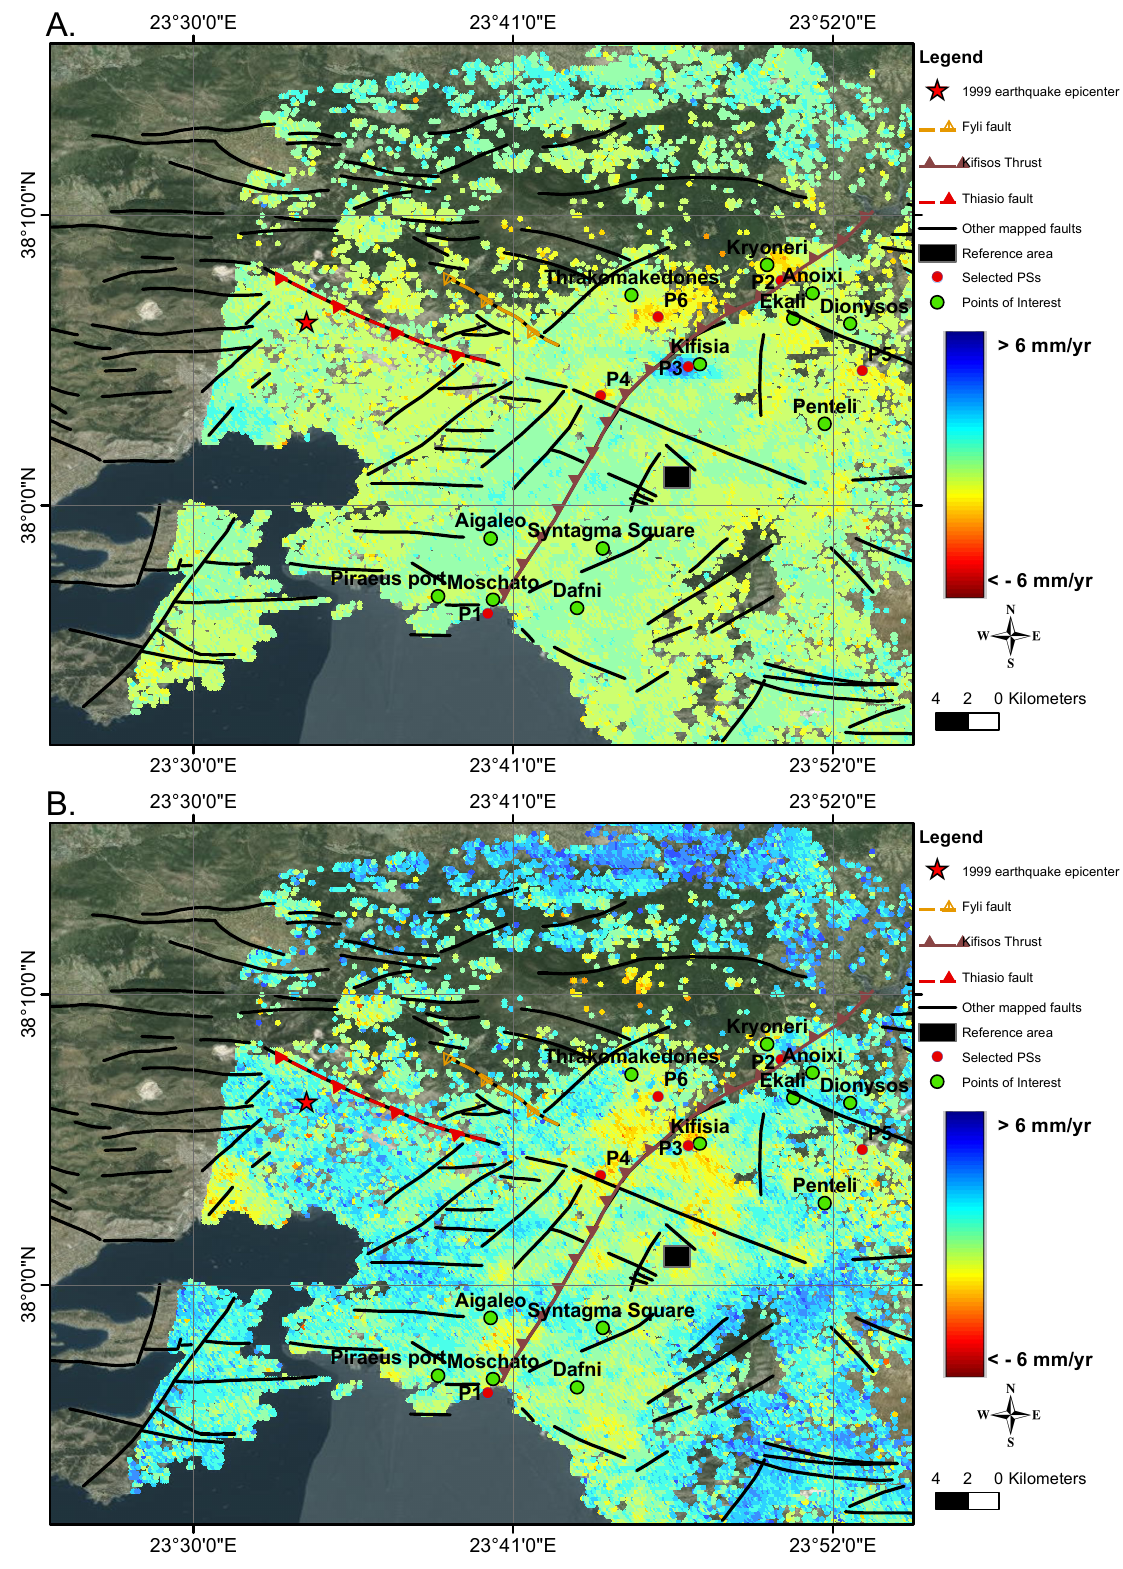
Figure 9. ( A ) Vertical and ( B ) horizontal velocities overlaid with the fault network in wider Athens for the 2002–2010 period. Negative values in the up direction correspond to subsidence, while positive values in the horizontal direction correspond to westward motion. Kifisia, previously subsiding, is now in uplift. The counter-force zones present in Figure 8B have disappeared, i.e., the 1992–1999 eastward motion of Parnitha Mountain has halted in the post-earthquake